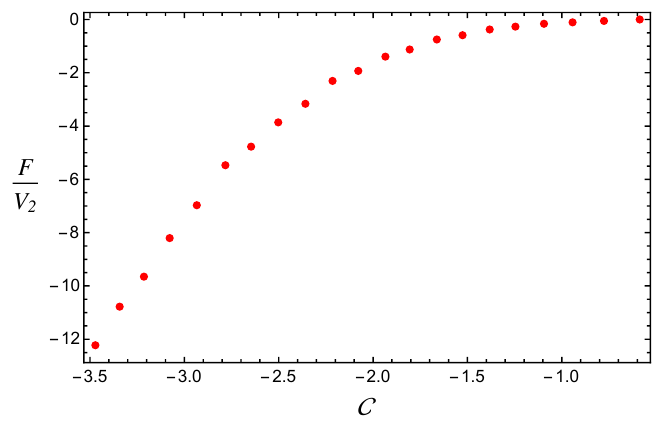
Figure 3 . Dependence of the free energy on the constant C de(cid:12)ned in (C.5). It is clear that when the magnitude of the latter one becomes larger the free energy become more negative. One should keep in mind that, for a given coupling f , the solution to the equations of motion is unique | see sections 3.1 and 5. Di(cid:11)erent values of C therefore do not corresponds to di(cid:11)erent states of the same solid but rather to solids obtained from di(cid:11)erent